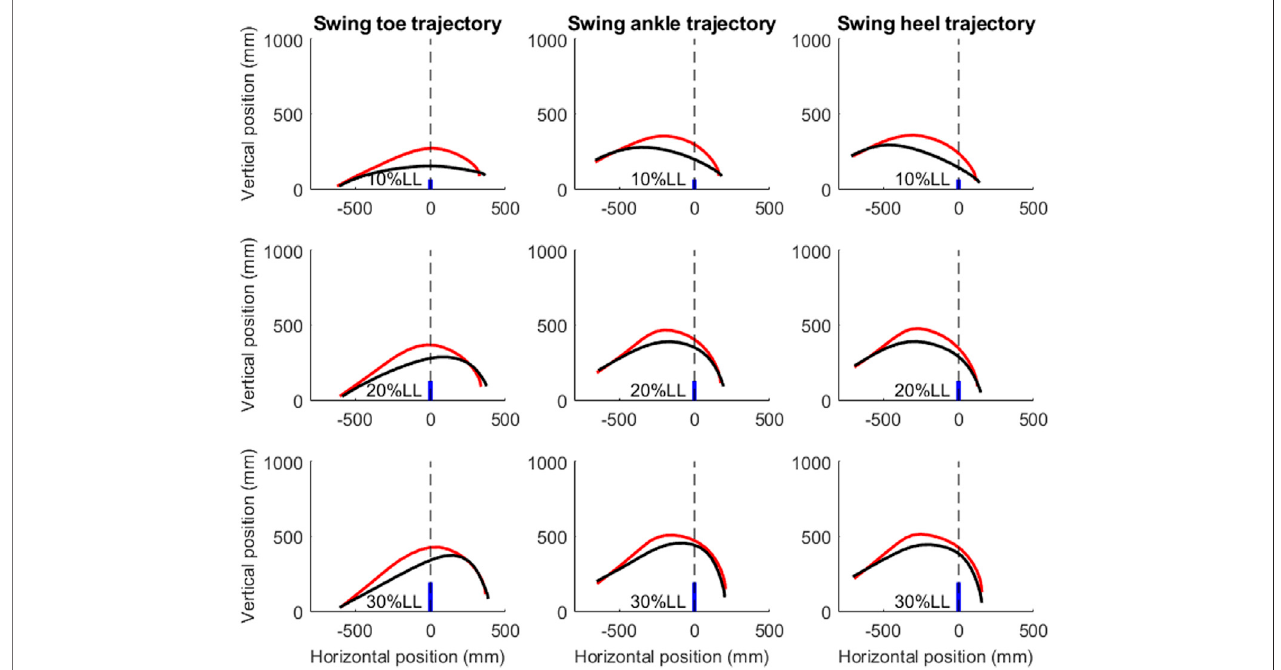
FIGURE 3 | Sagittal trajectories of the toe, ankle, toe, and heel of the leading swing limb of a typical subject for each of the TCC (red curves) and control (black curves) groups when crossing obstacles of 10, 20, and 30% of the subject ’ s leg length (LL) (solid blue lines).